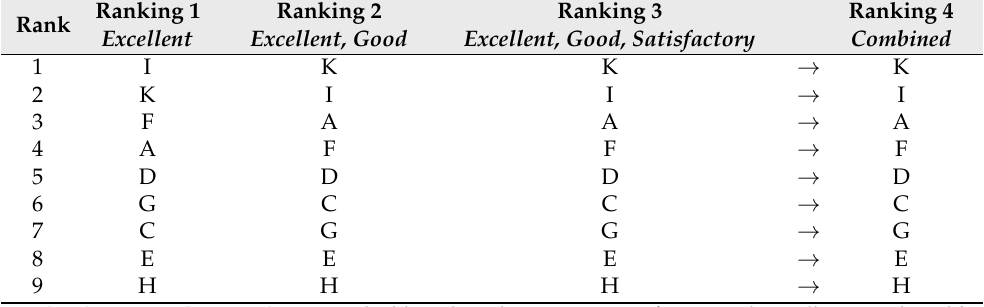
Table 2. Class-ranking of all